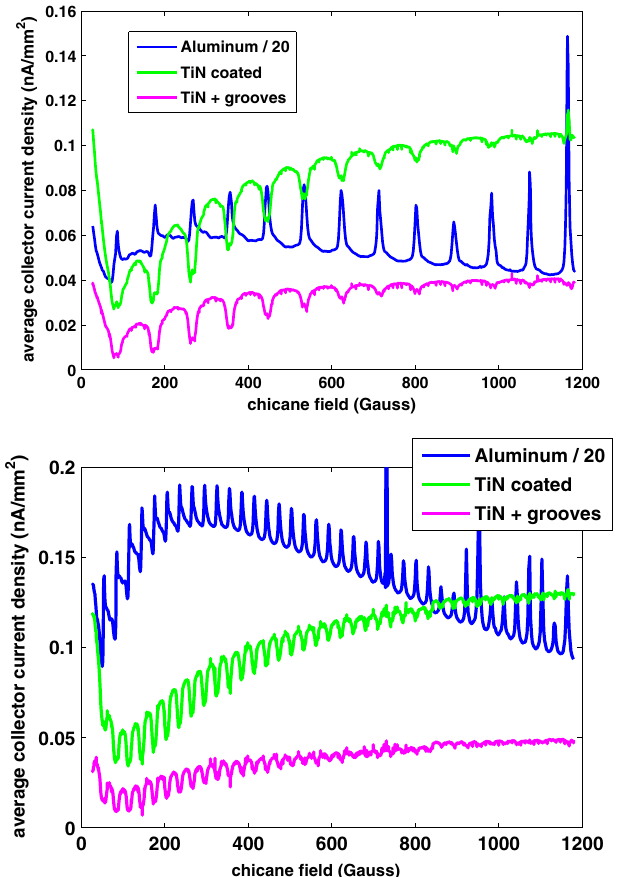
FIG. 7. RFA signal as a function of chicane magnetic field: 1 × 45 × 1 mA e þ , 5 GeV. Top: 4 ns spacing. Bottom: 12 ns spacing. Cyclotron resonances are observed every 89 gauss with 4 ns spacing, and every 30 gauss with 12 ns spacing, as predicted by Eq. (2). Note that the aluminum chamber signal is divided by